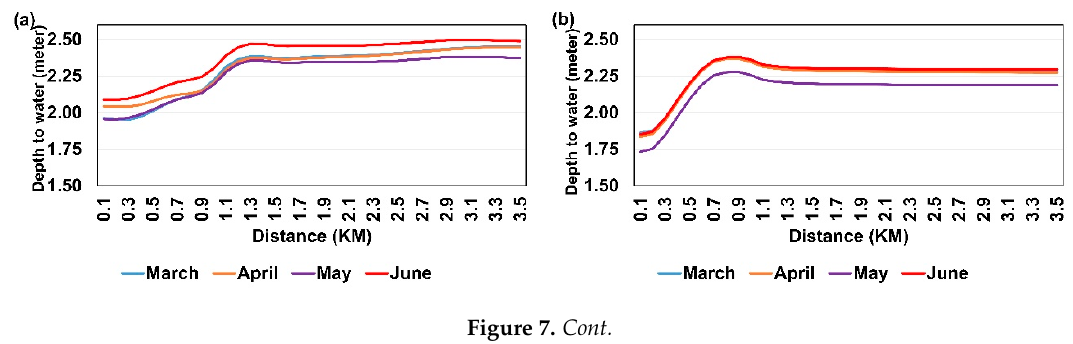
Figure 6. Variation of electrical conductivity along the gradient of different zones in the study area: ( a ) northern zone, ( b ) eastern zone, ( c ) southern zone, and ( d ) western zone.